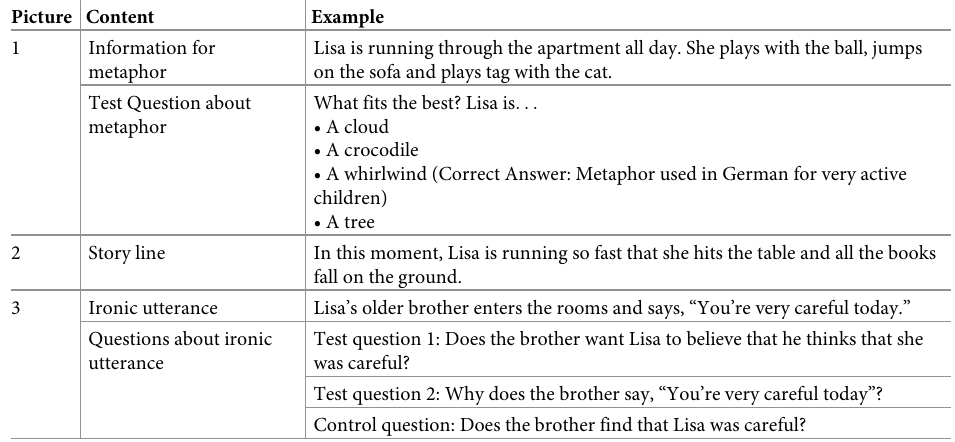
Table 2. Example story for Advanced Pragmatics Understanding